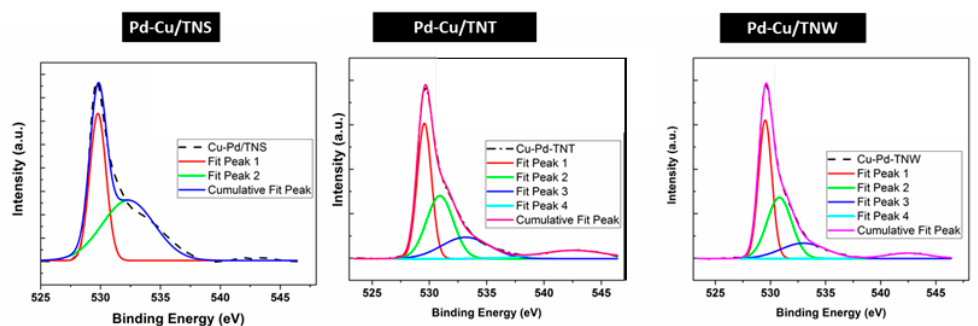
Figure 5. Peak deconvolution for Pd 3d for Pd-Cu/TNS, Pd-Cu/TNT, and Pd-Cu/TNW.